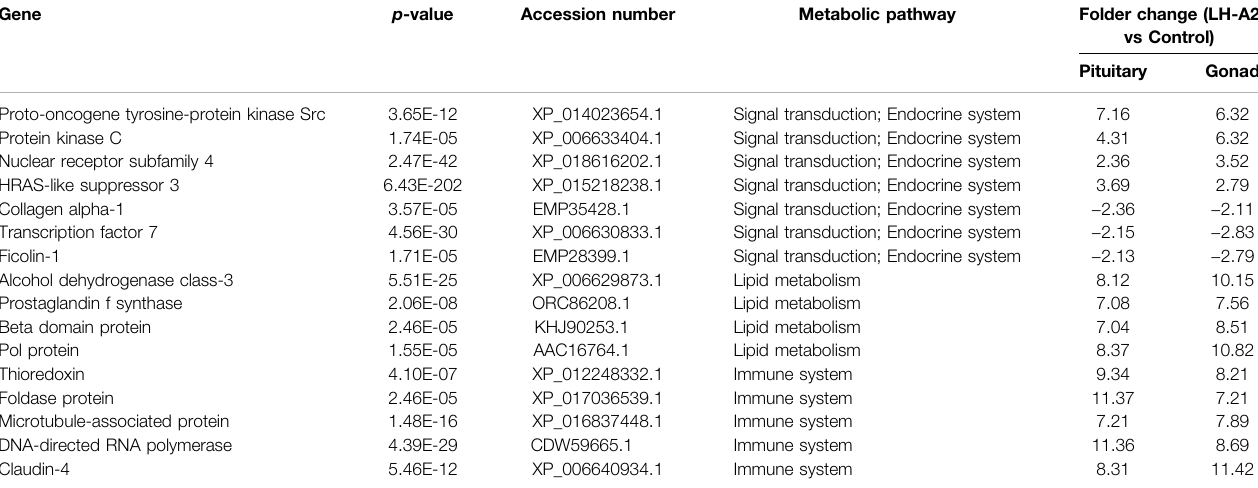
TABLE 2 | Selected DEGs involved in the gonad development of A . schrenckii . Gene p -value Accession number Metabolic pathway Folder change (LH-A2